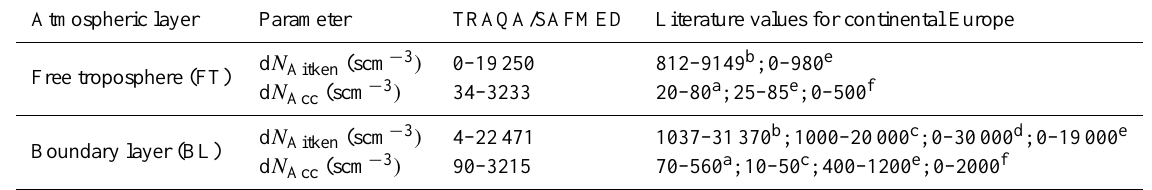
Table 2. Comparison of the number concentrations d N Aitken (0.004–0.1µm) and d N Acc (0.1–1.0µm) observed during the TRAQA/SAFMED field campaigns with those reported in literature for continental Europe. All literature data refer to airborne measurements.